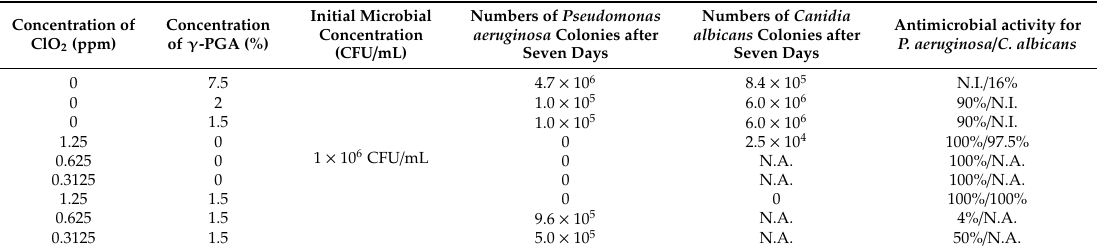
Table 1. The antimicrobial results of contact lens care